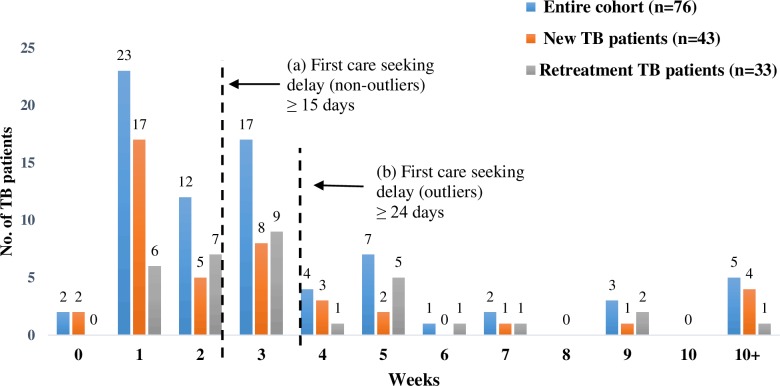
First Care Seeking: Duration and Delays.The figure represents the time taken from onset of symptoms suggestive of TB to first contact with any health care provider. The serrated lines depict the durations that reflect (a) delay and (b) outliers.